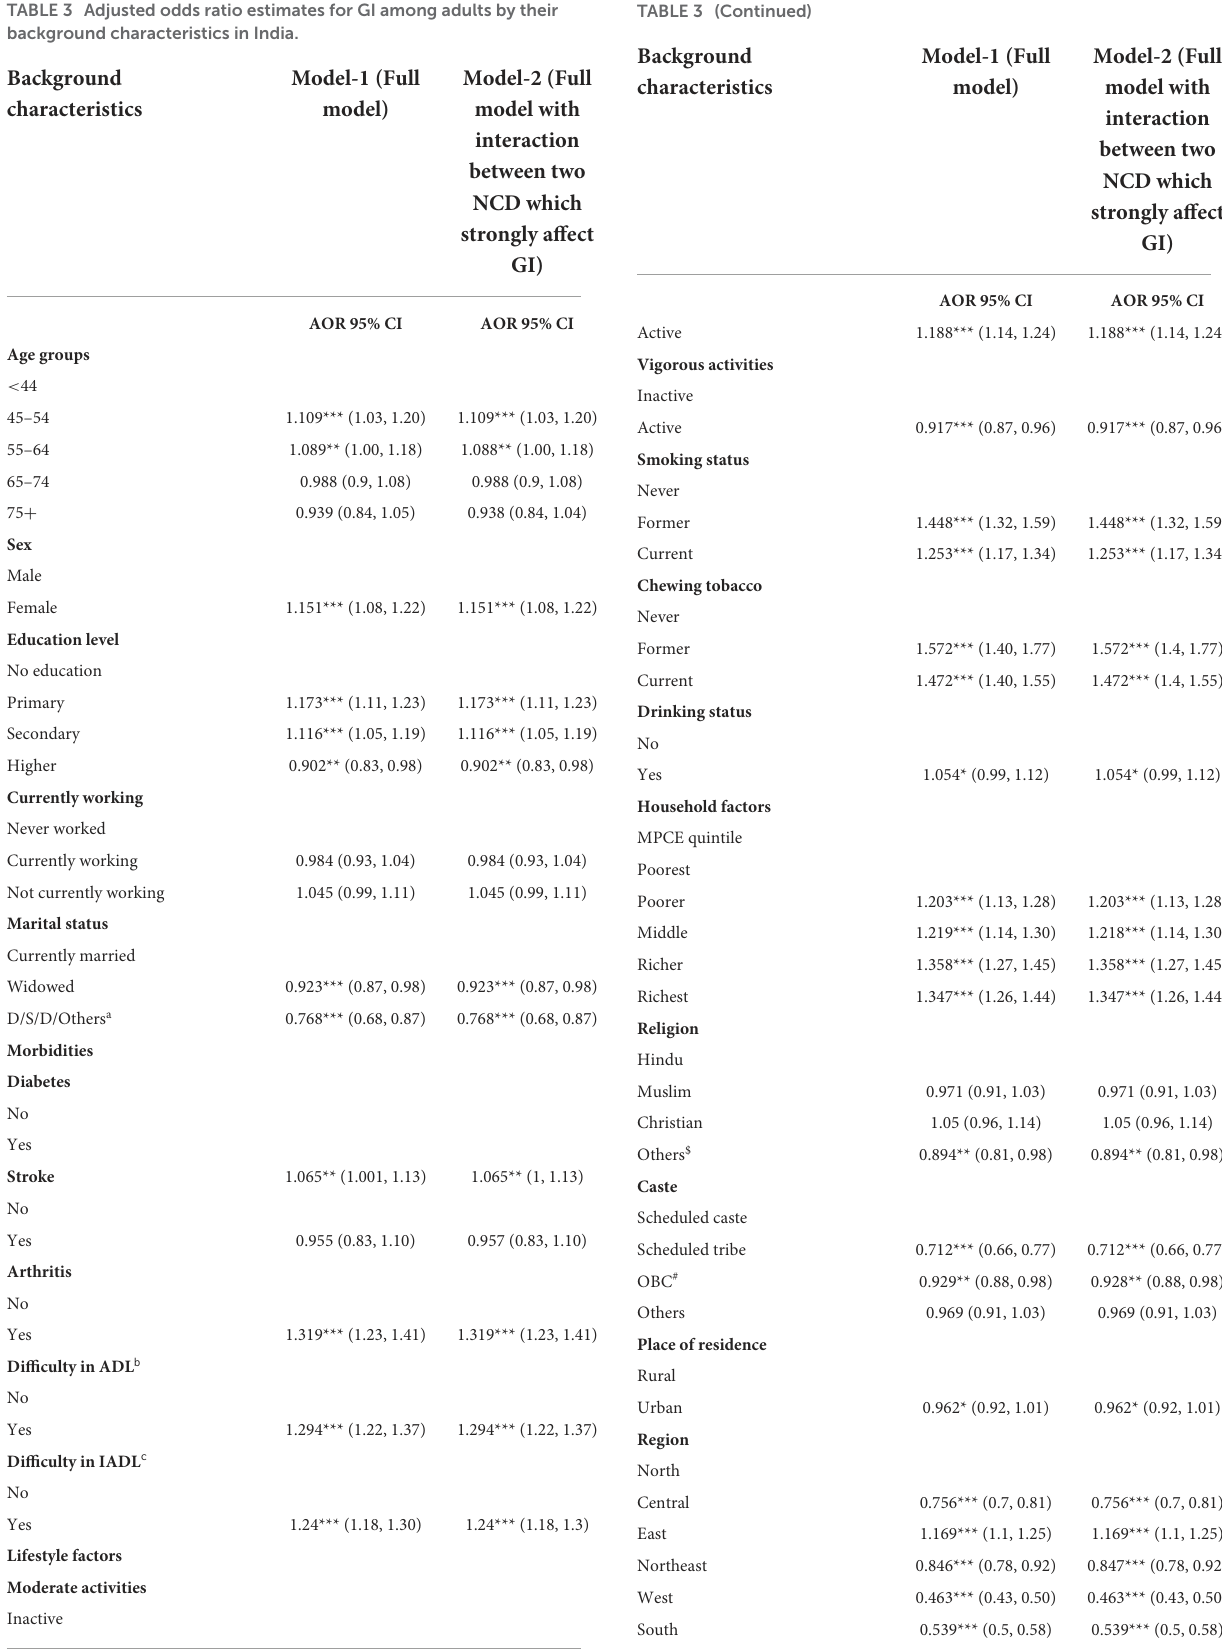
TABLE 3 Adjusted odds ratio estimates for GI among adults by their background characteristics in